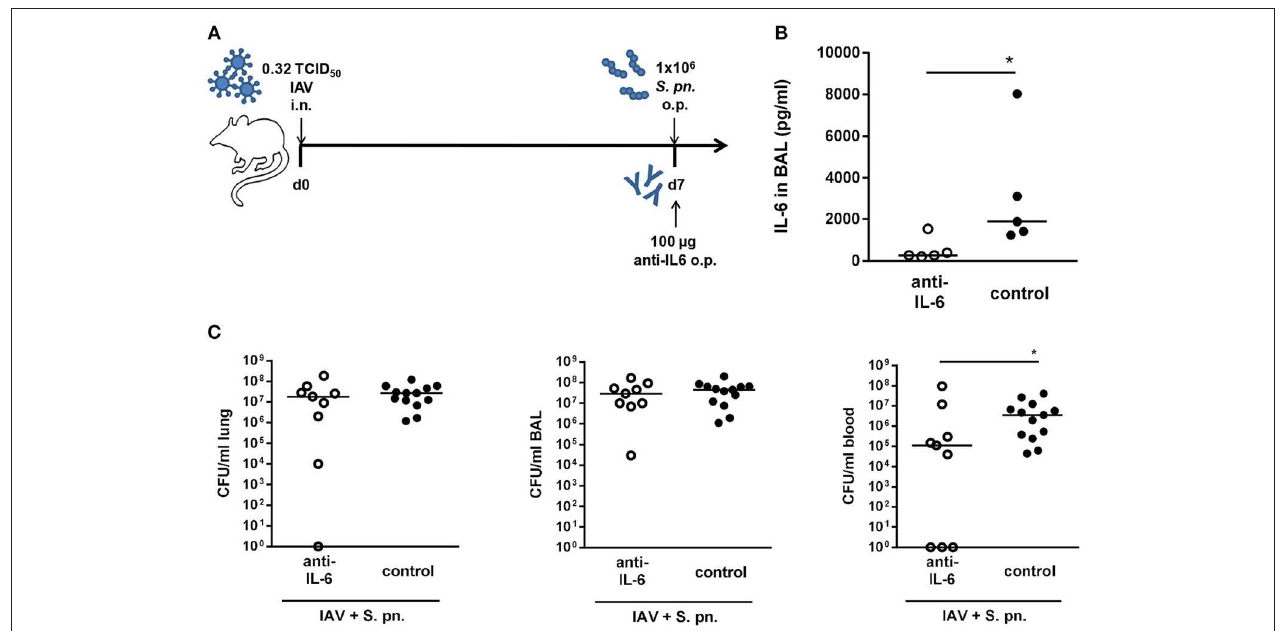
FIGURE 2 | Single IL-6 neutralization during co-infection with 0.32 TCID 50 IAV and 1 × 10 6 CFU S. pn. Mice were infected intranasally (i.n.) with 0.32 TCID 50 IAV on day 0. On day 7, mice were treated with anti-IL-6 antibody and infected with 1 × 10 6 CFU S. pn. oropharyngeally (o.p.). The control group was infected likewise and treated with an isotype IgG antibody. (A) Experimental setup. (B) IL-6 protein levels in bronchoalveolar lavage (BAL) 24h post antibody treatment and S. pn. infection. (C) S. pn. bacterial counts in lung tissue, BAL and blood 24h post antibody treatment and S. pn. infection. Data are shown for individual mice and lines indicate the median/group. Controls in (C) are compiled from independent experiments. Statistical analysis was performed using the unpaired, one-sided Mann-Whitney test (* p < 0.05). CFU data are compiled from at least two independent